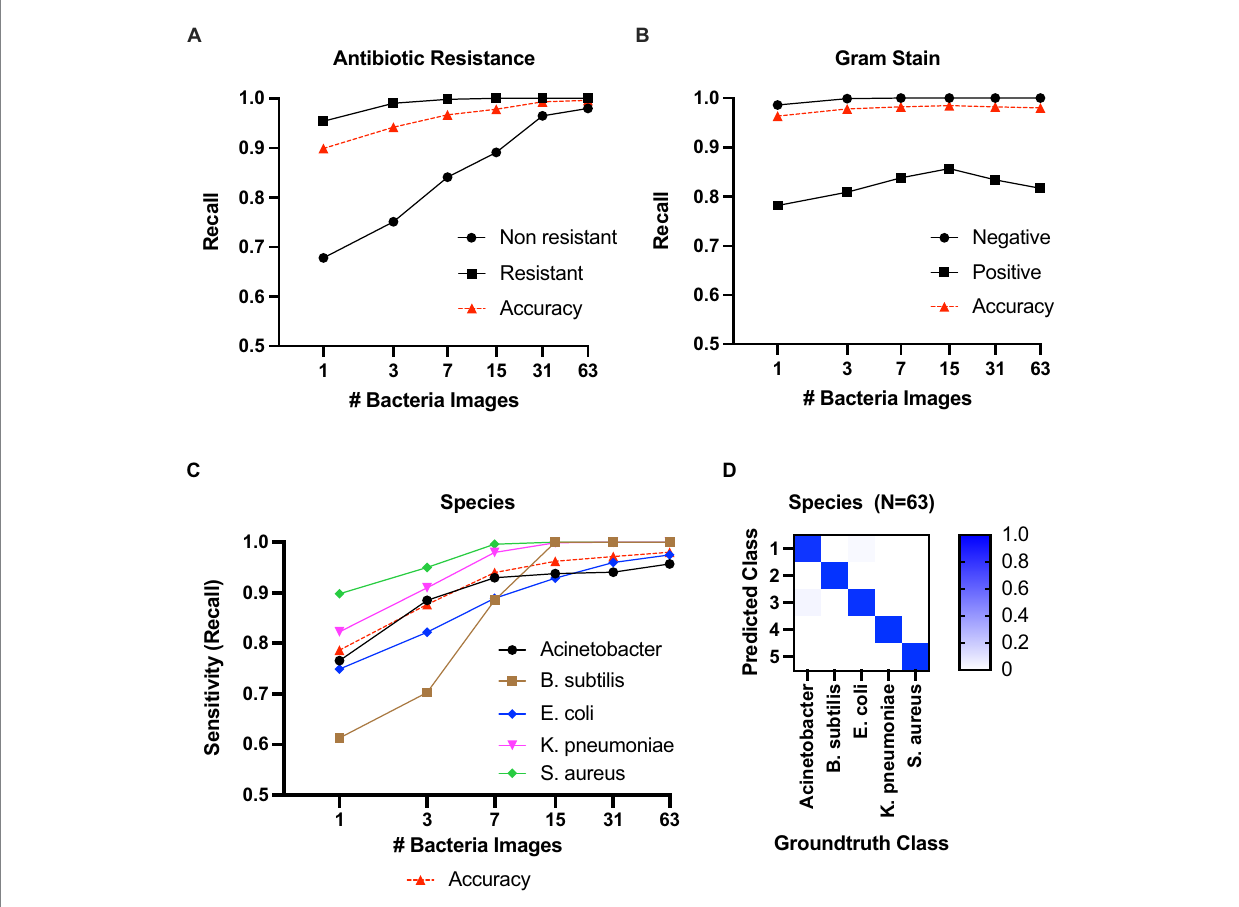
FIGURE 7 Classification results against the number of bacteria images. (A) Classification recall scores for antibiotic resistance. (B) Classification recall scores for gram +/ − ve. (C) Species-level classification sensitivity score. (D) Confusion matrix for species-level classification with 63 bacteria images in the